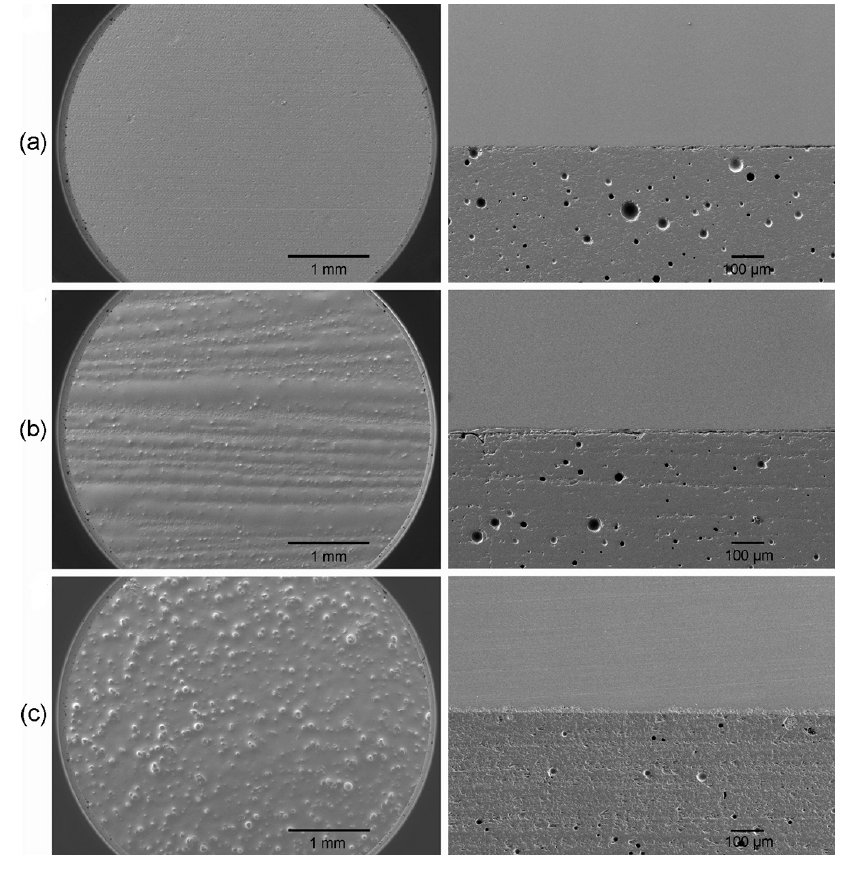
Figure 1. SEM image showing the zirconia specimen surface for each group ( Left , 25×, b , c : taken after firing of the liners) and the cross-sectional morphology of zirconia/porcelain interface ( Right , 100×). ( a ): Group NL; ( b ): Group CL; and ( c ): Group EL3.